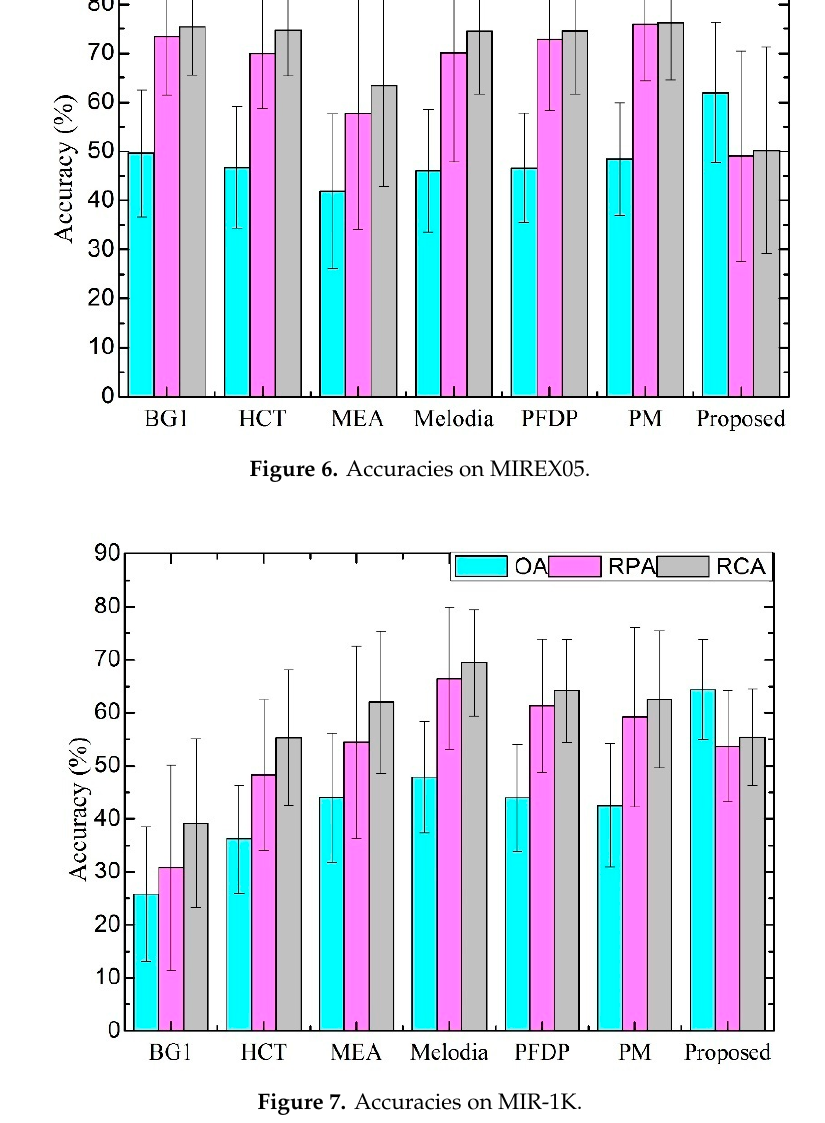
Figure 7. Accuracies on MIR-1K.